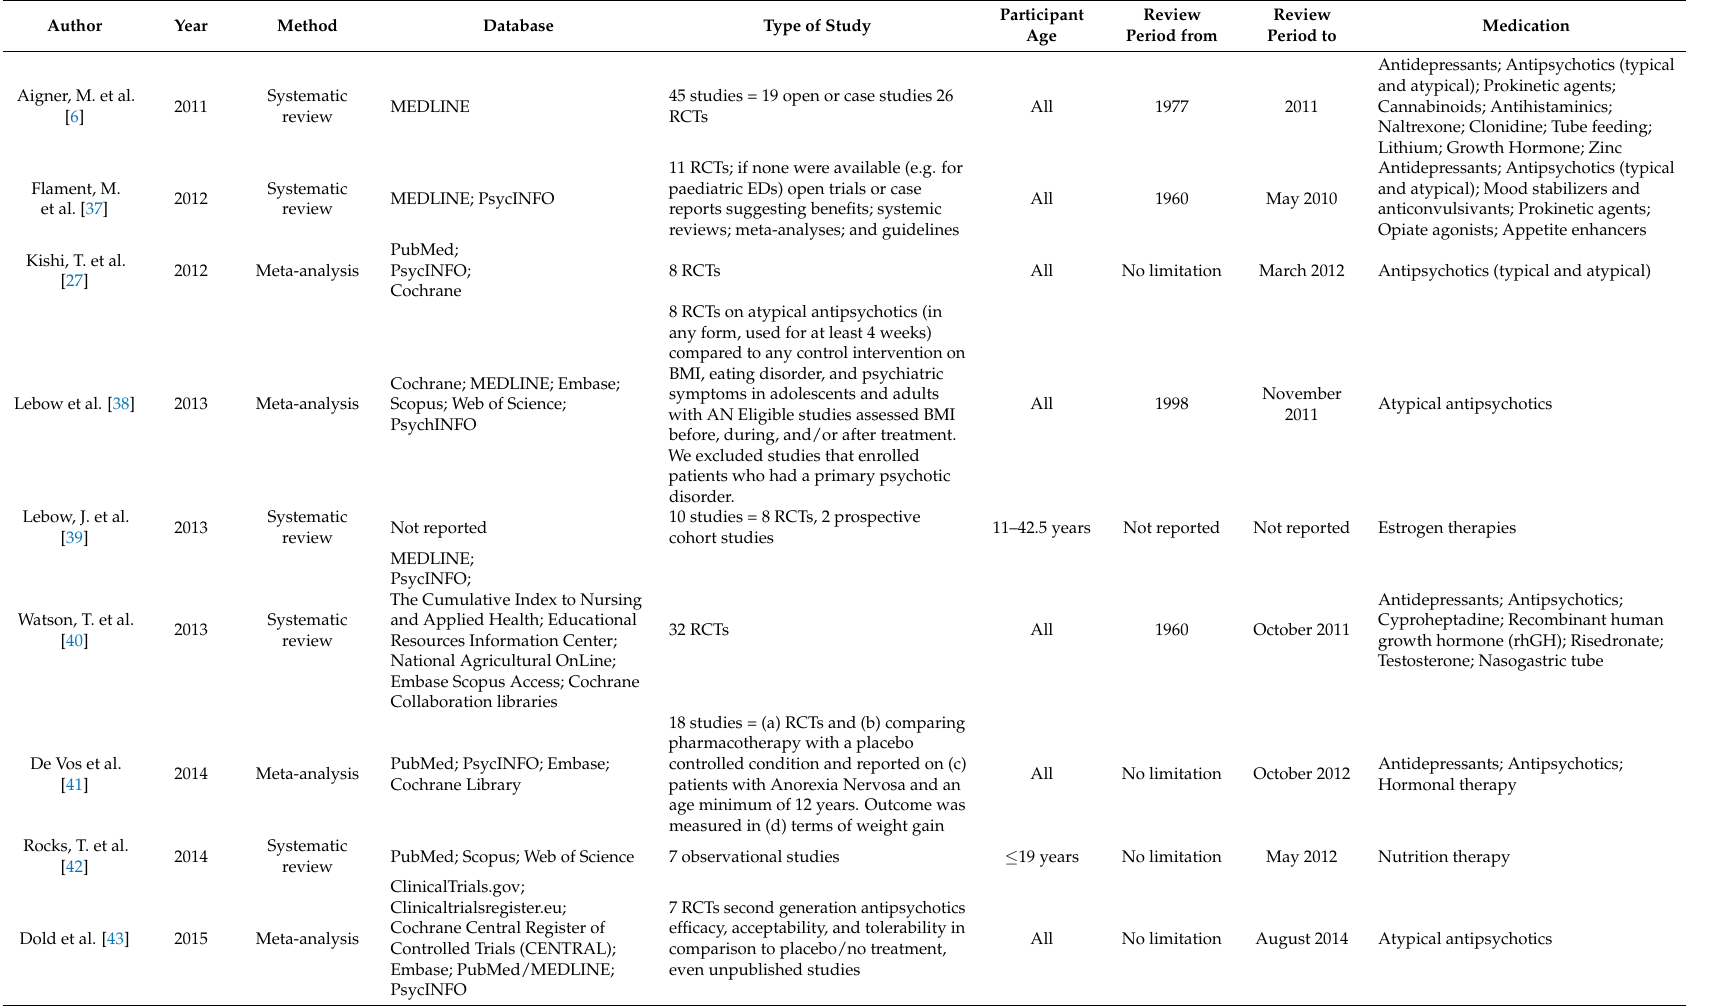
Table 3. Meta-analyses and systematic reviews